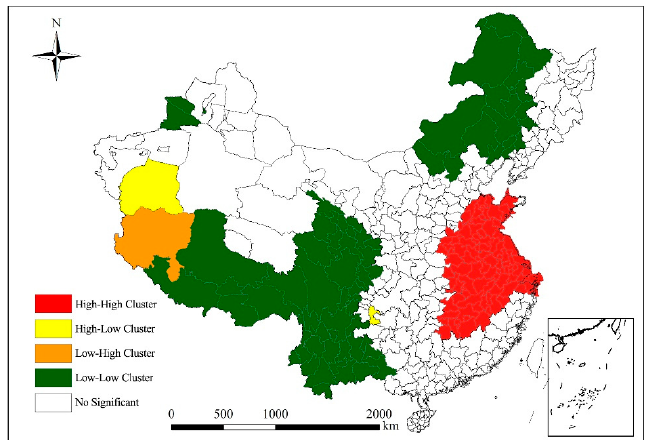
Figure 2. Spatial distribution of PM 2.5 levels at prefecture-city level in China.